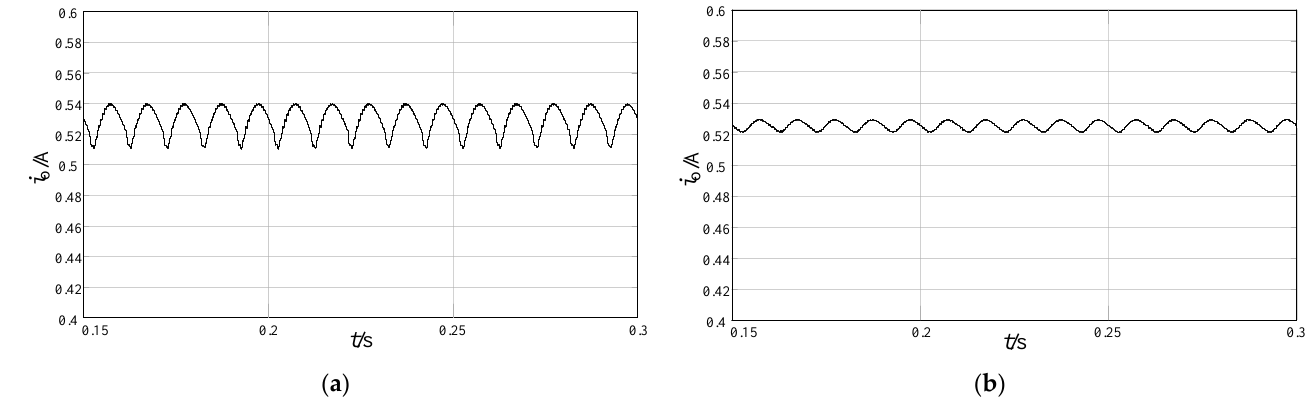
Figure 17. Output current ripple: ( a ) conventional double closed-loop control; ( b ) model current prediction control.